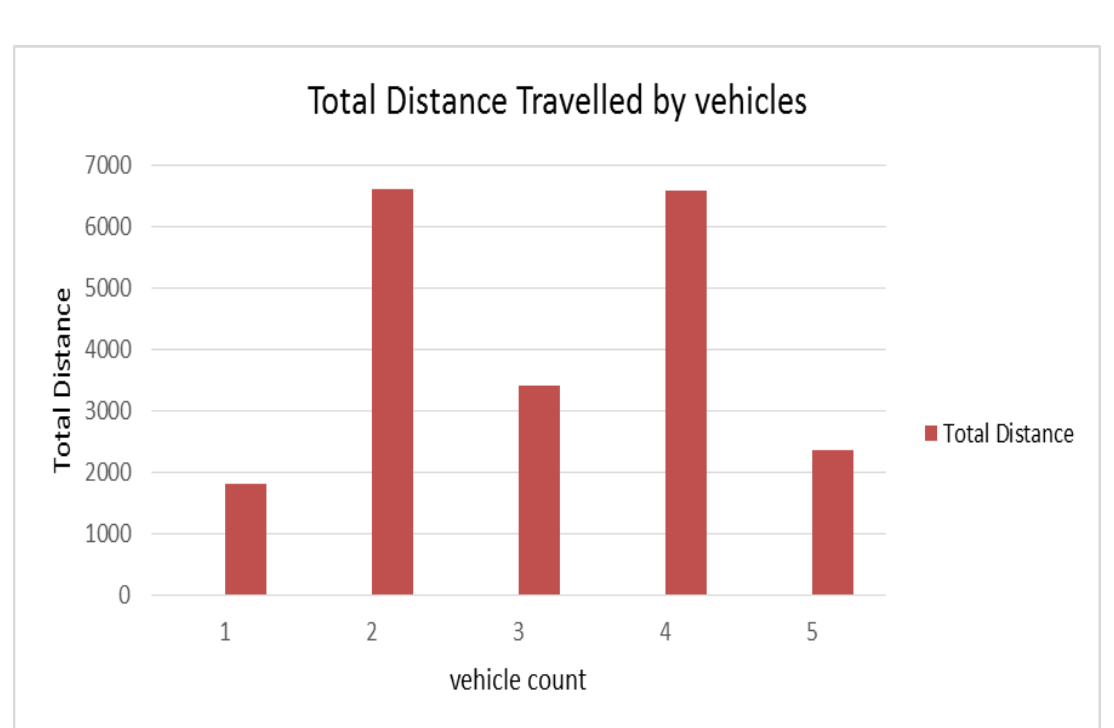
Figure 19. Total Distance Travelled by